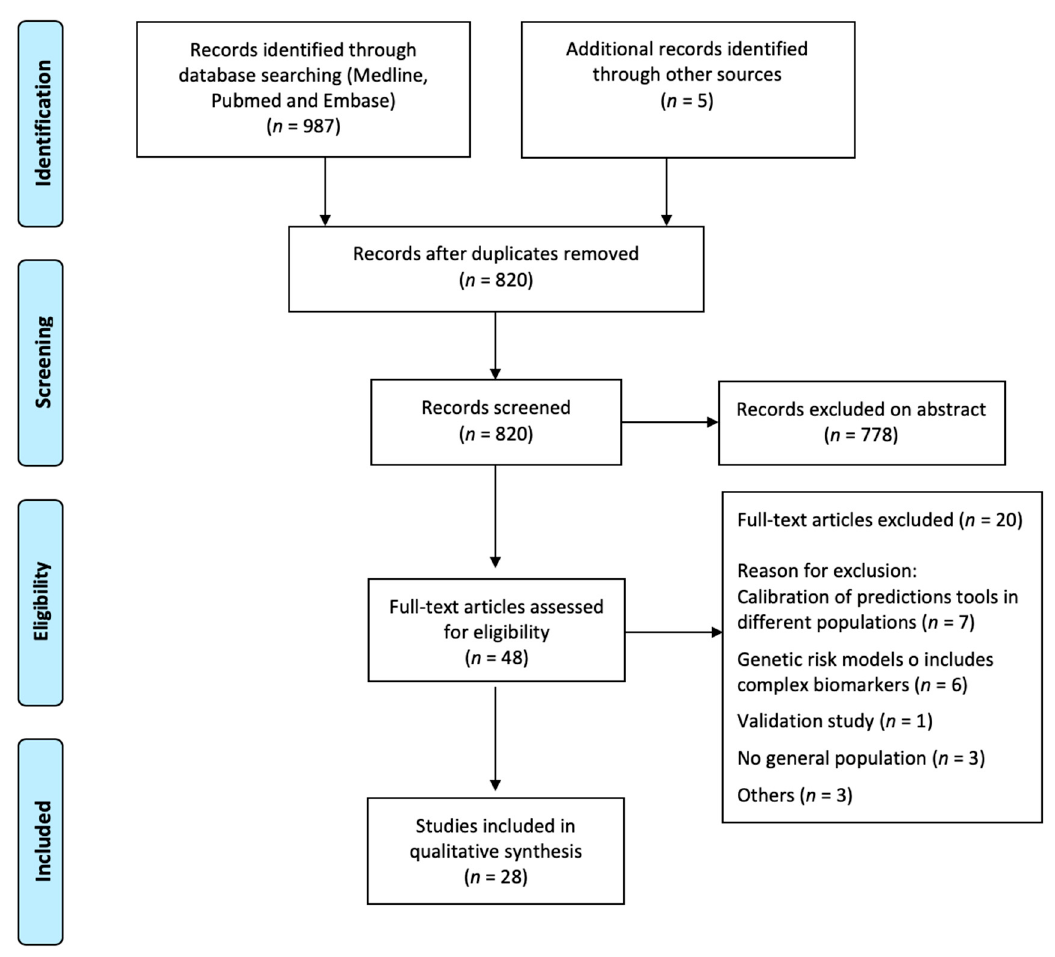
Figure 1. Flow diagram of selected studies.